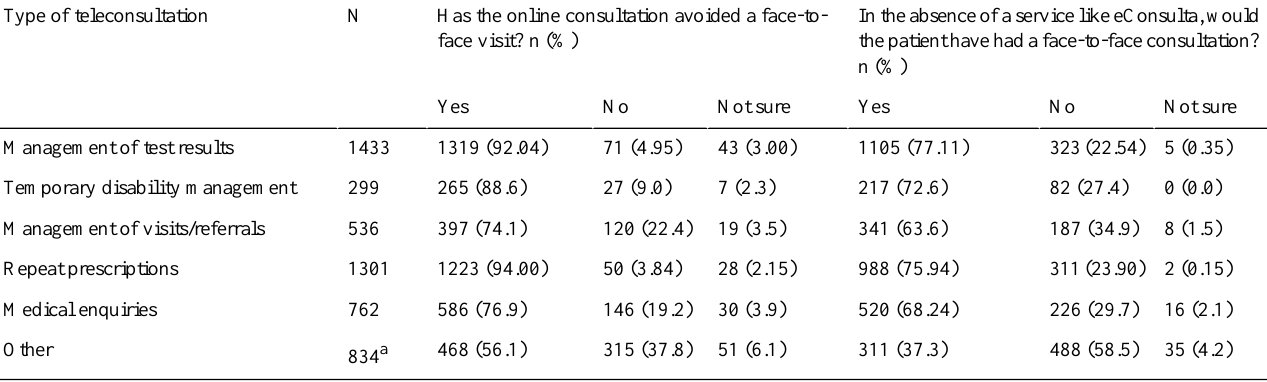
Table 2. Relationship between the type of consultation and the two other variables recorded.